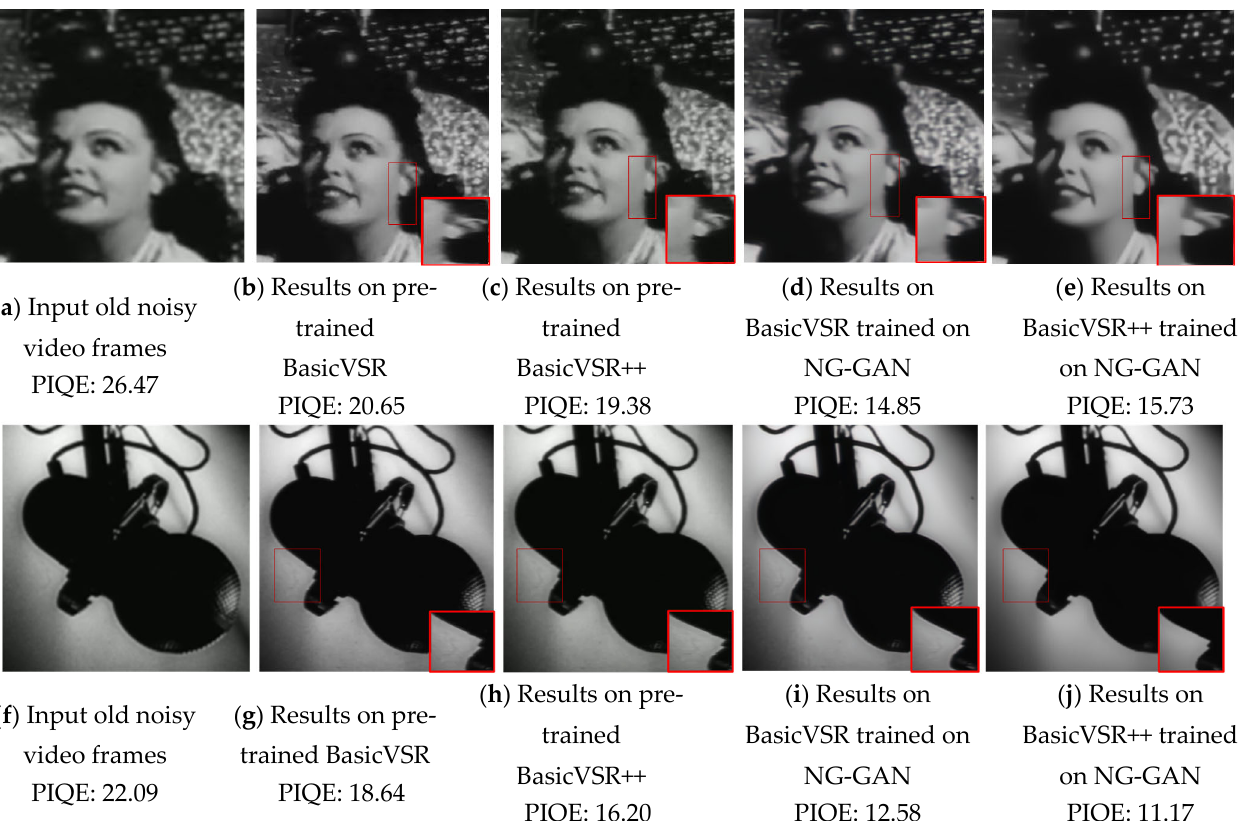
Figure 7. Examples of de ‐ oldifying old videos using pretrained SOTA methods and SOTA methods trained on NG ‐ GAN generated dataset. ( a ) Old video frames, ( b ) de ‐ oldified output from pre ‐ trained BasicVSR, ( c ) de ‐ oldified output from pre ‐ trained BasicVSR++, ( d ) de ‐ oldified output from BasicVSR trained on the proposed NG ‐ GAN generated datasets, and ( e ) de ‐ oldified output from BasicVSR++ trained on the proposed NG ‐ GAN ‐ generated datasets.